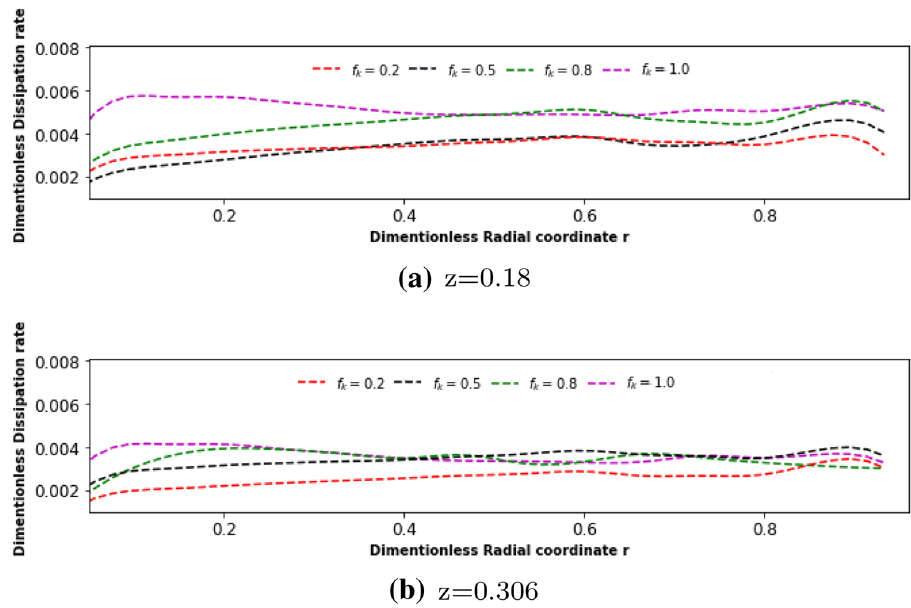
Fig. 12 Profiles for turbulent energy dissipation rate below the impeller at different z-location for f k = 0.2 ( - - - ), = 0.5 ( - - - ), f f k = 1.0 ( - -- ) of PANS k f k